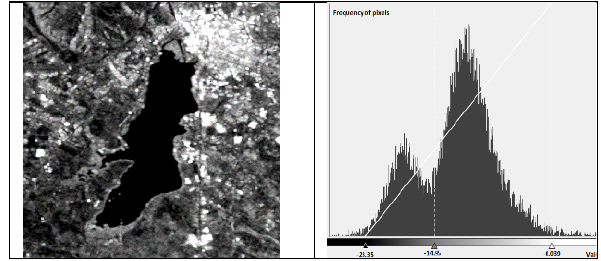
Figure 5. Mogan Lake surroundings and histograms of arithmetic mean of pre-event images.